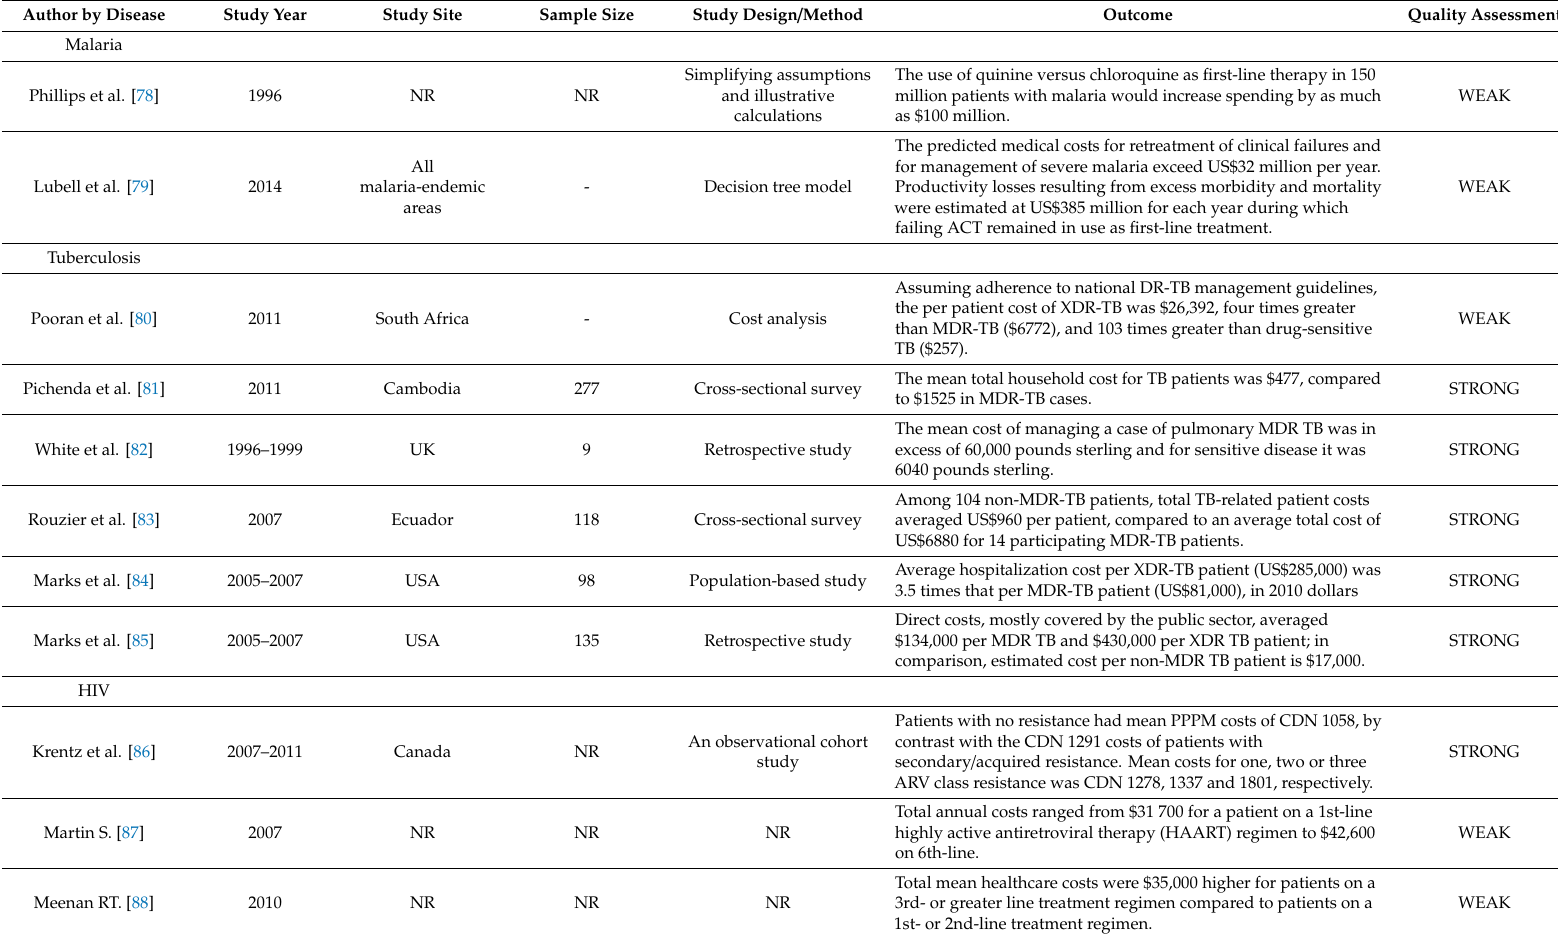
Table 3. Characteristics of included studies on economic outcomes due to